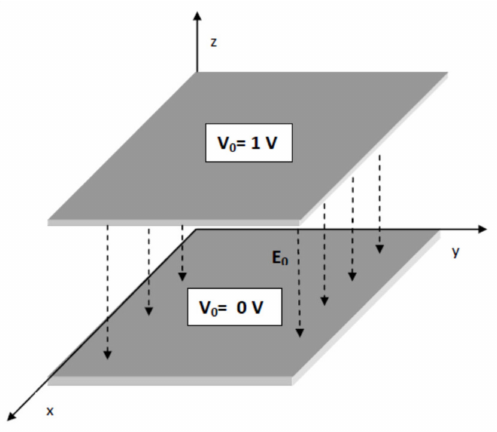
Figure 9. Planar geometry used for the calculation discussed in this